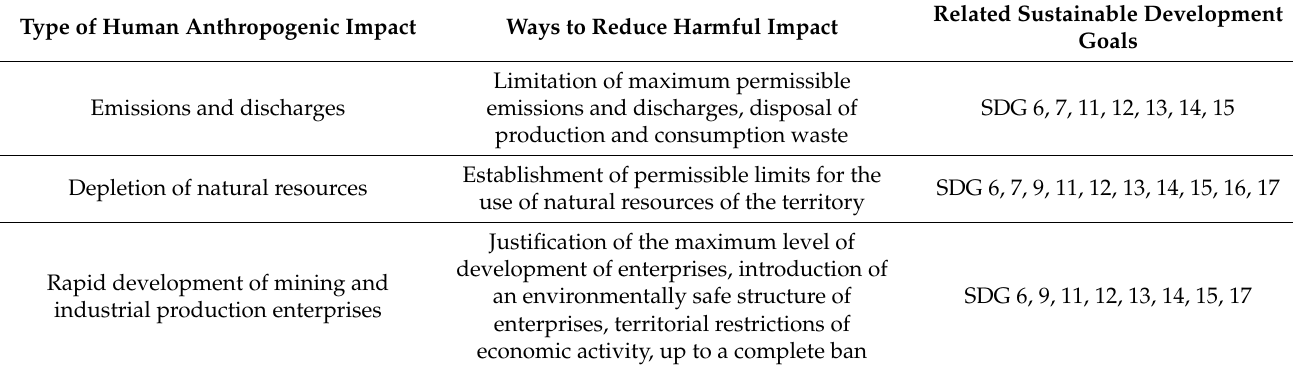
Table 1. Main global problems of human anthropogenic